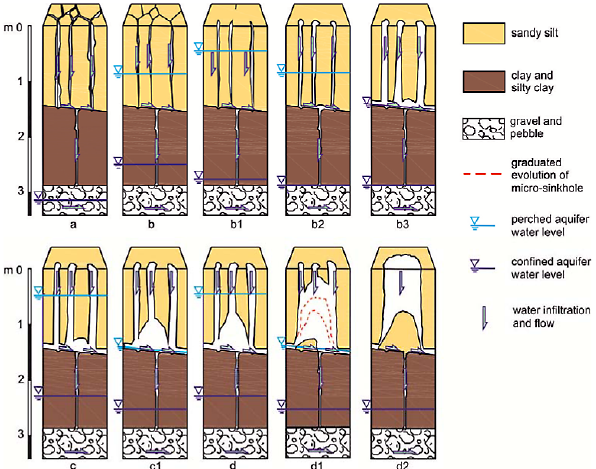
Fig. 13. Evolution sequence of sinkhole-like features produced by water flow between perched and confined aquifers: (a) dry period; (b) during and after rainy periods; (c) following rainy cycle; (d)